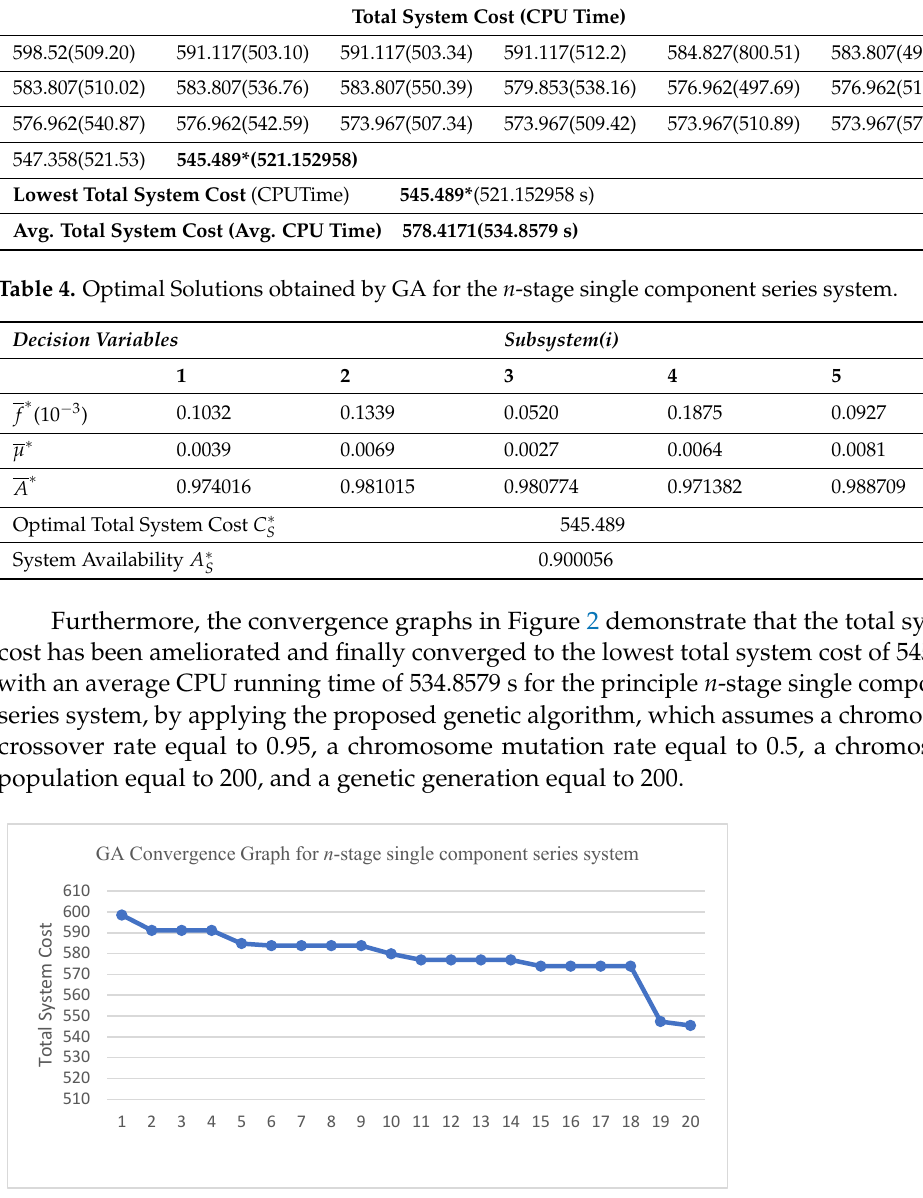
Figure 2. The convergence graph of n -stage single component series system by conducting genetic Figure 2. Theconvergencegraphof n algorithm.